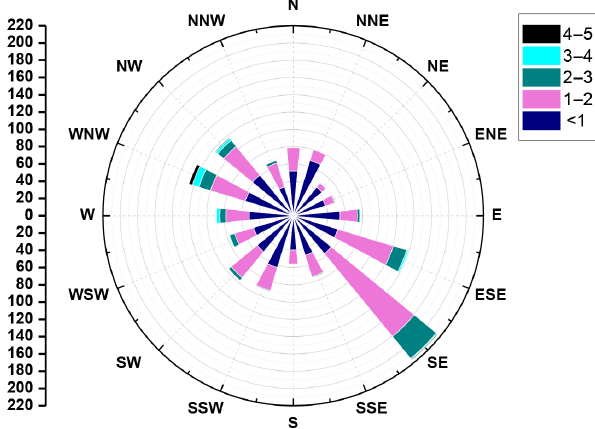
County, Baoding, Hebei Province, and it is about 110 km